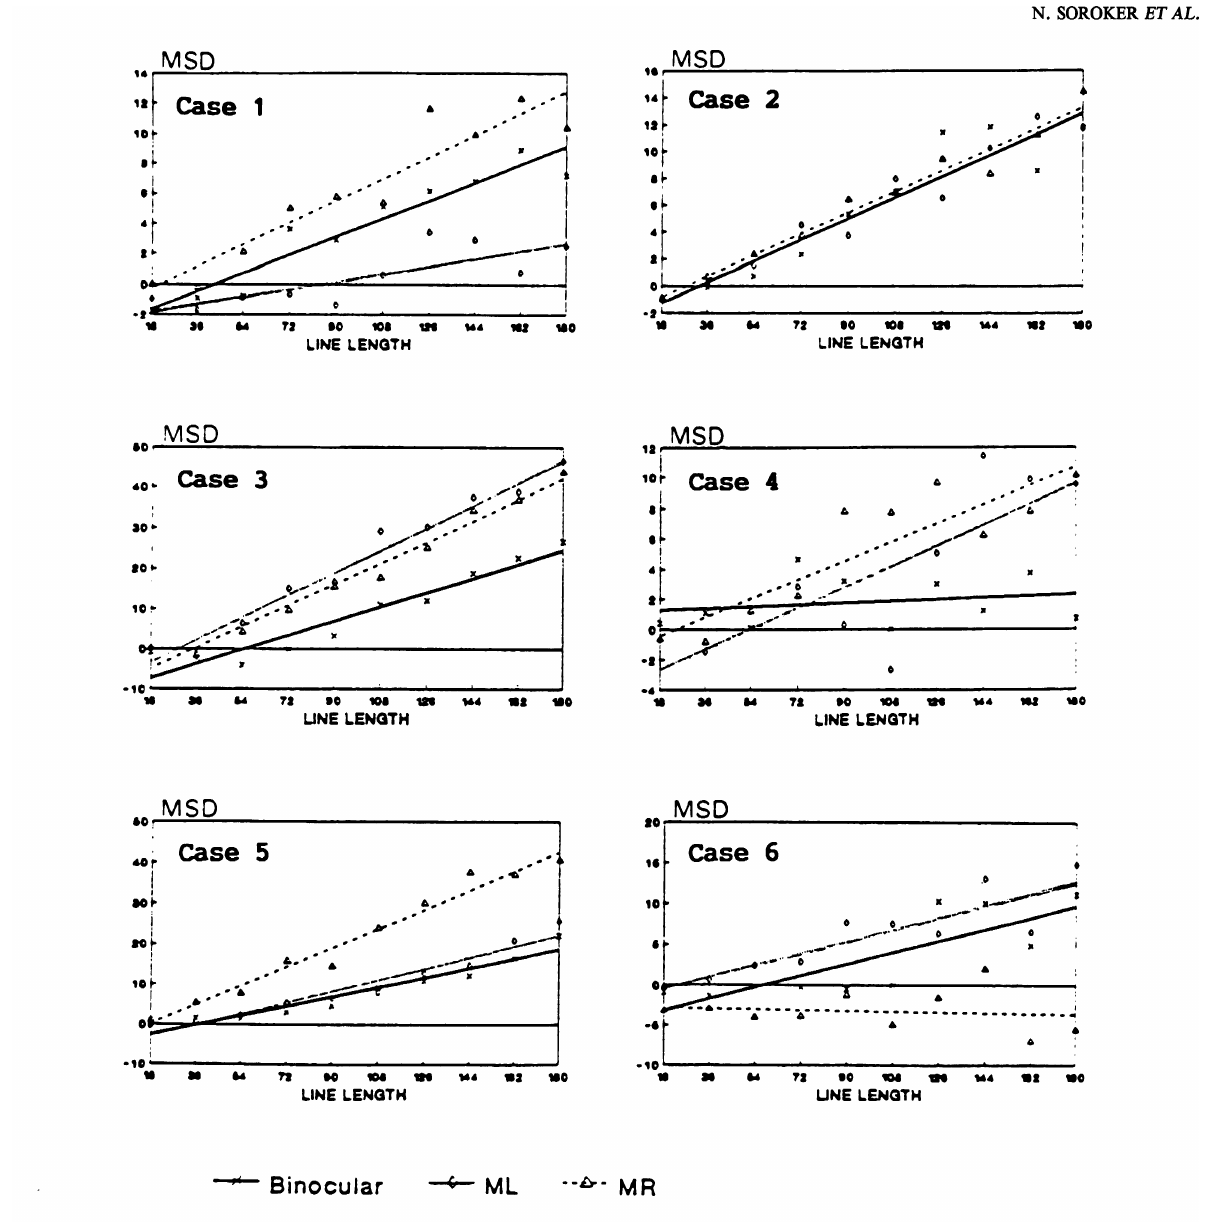
FIG. 2. Mean signed displacement (MSD, in mm), as a function of line length (in mm). Individual regression lines for each viewing condition are represented separately for each of the six patients.